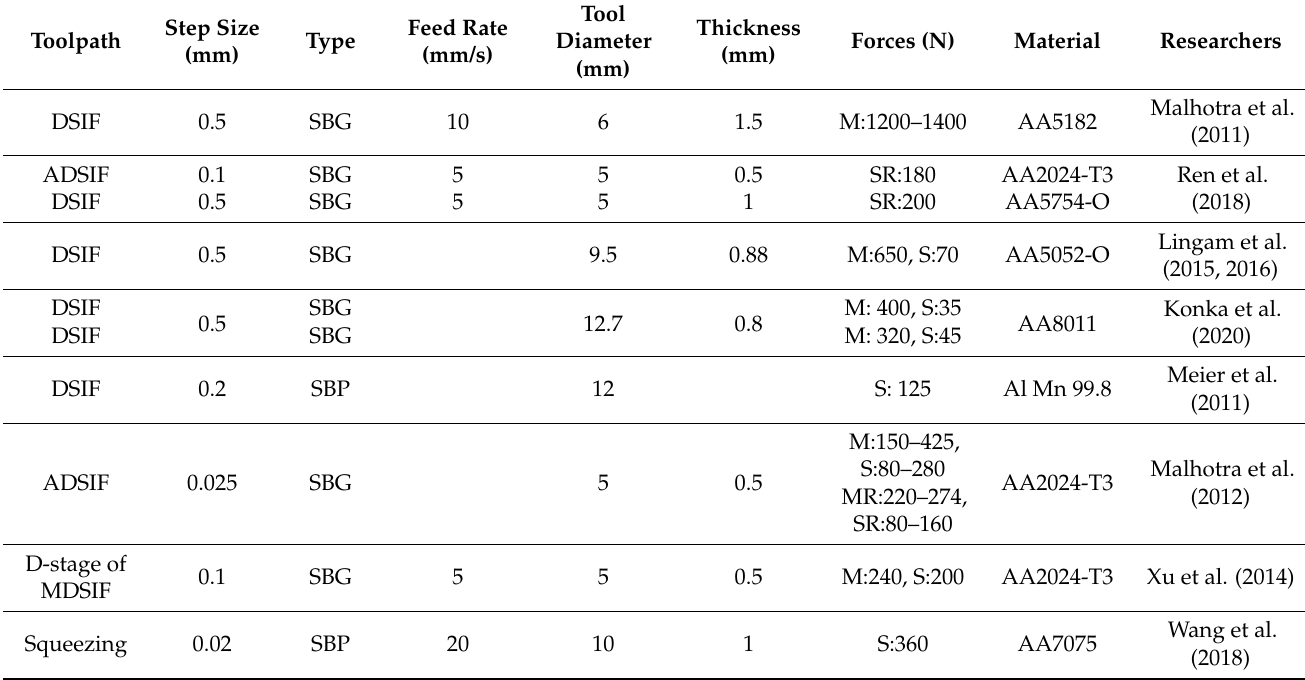
Table 4. Master and support tool force requirements in different toolpath